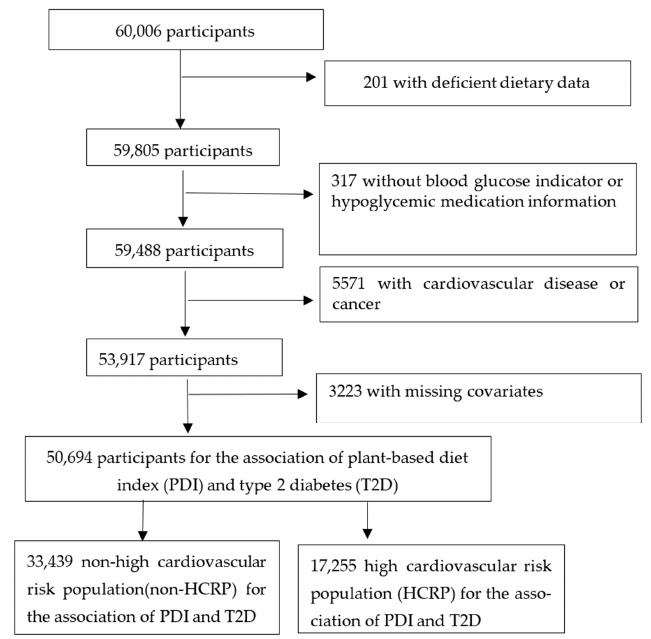
Figure 1. Flow chart of participant